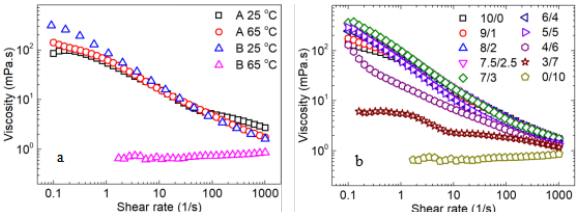
Fig. 3. Cryo TEM images of cetylamidopropyl hydroxypropyl sulfobetaine/tetradecyl propyl sulfobetaine composite systems with different concentrations at 65 o